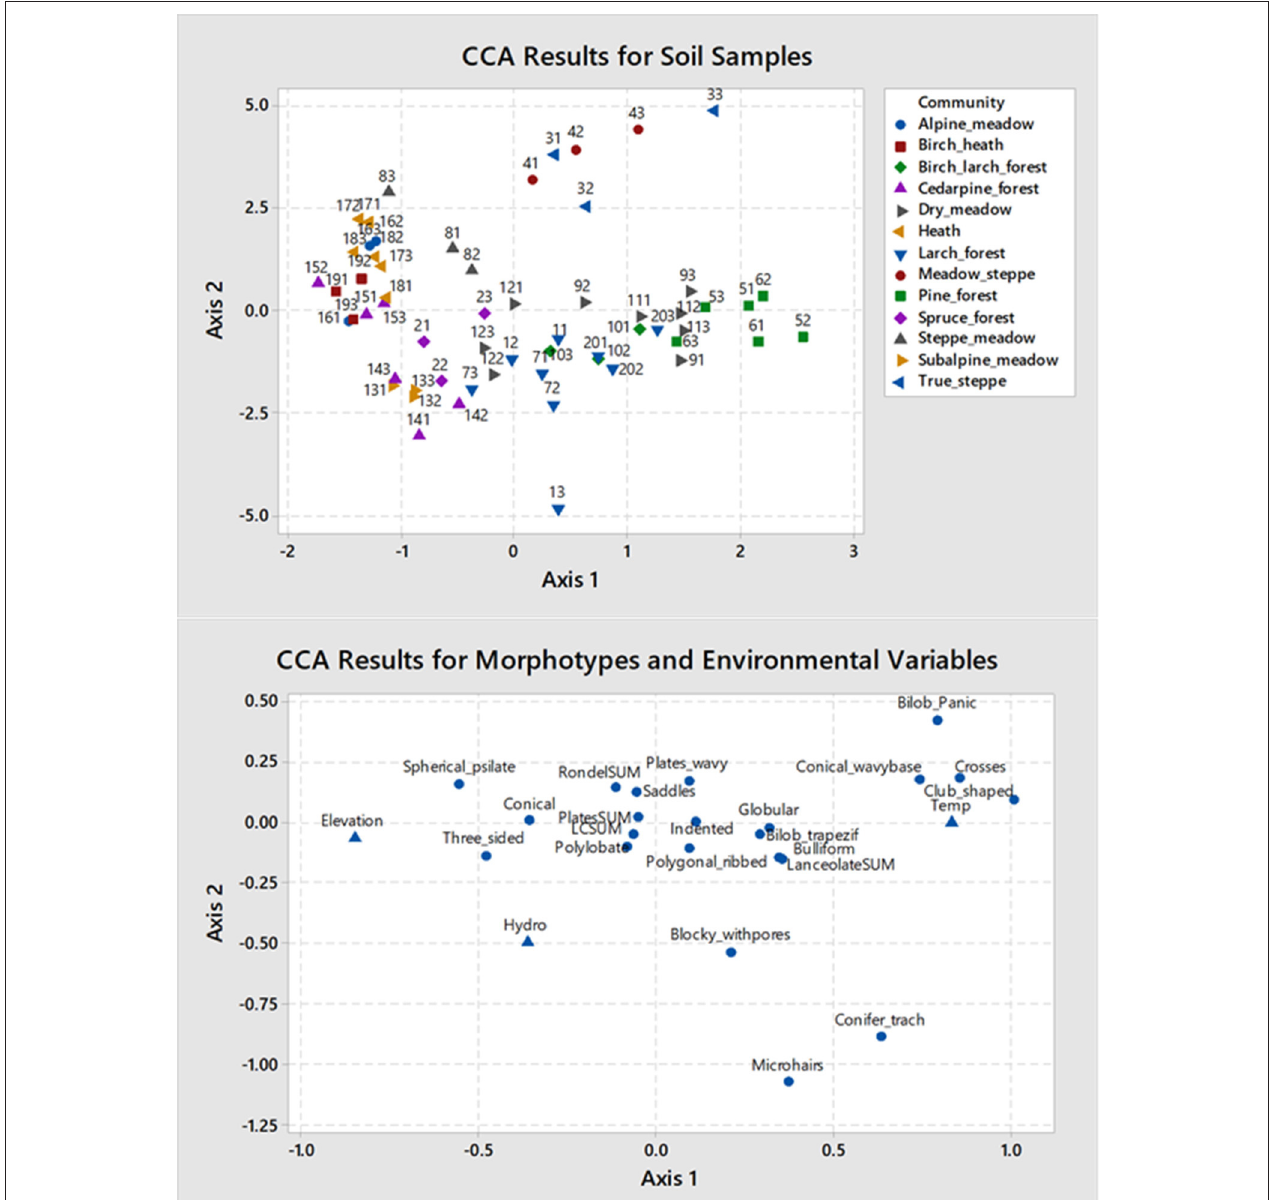
FIGURE 5 | Triplot showing ordination results by Canonical Correspondence Analysis. First two axes are